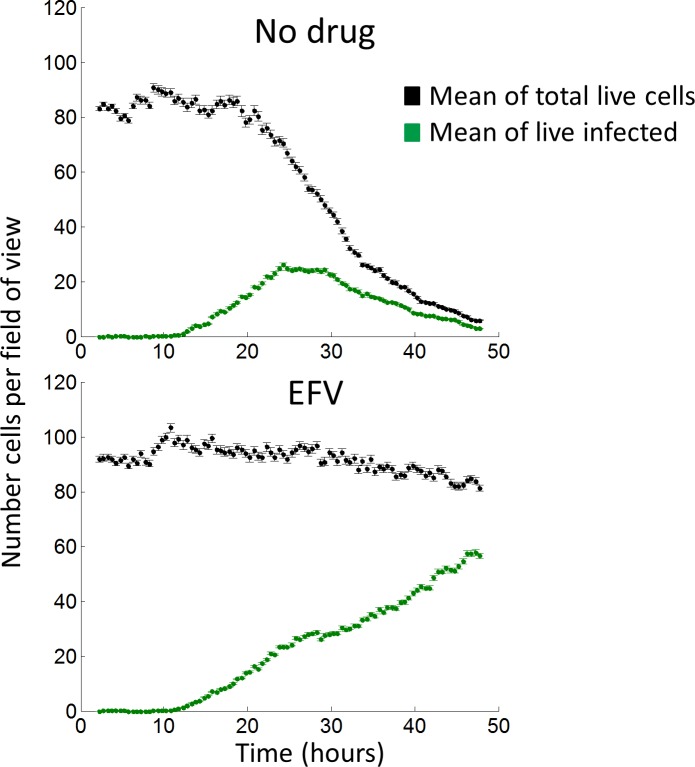
Time-lapse microscopy of HIV infection in the absence and presence of EFV.Infection was performed by an input of 20% infected mCherry-negative donor cells. Black points represent the number of total live cells, as detected by the presence of cellular mCherry fluorescence. Green points represent the number of live infected target cells, as detected by co-expression of mCherry and HIV-dependent GFP. Top graph shows infection in the absence of drug and bottom graph in the presence of 30 nM EFV. Time-lapse interval was 20 min between frames, and three independent experiments were performed with 15 fields of view per condition in each experiment. The 45 fields of view from three independent experiments were averaged, and each point is the mean and standard error of the number of cells per field of view. For clarity, every second measurement is shown.